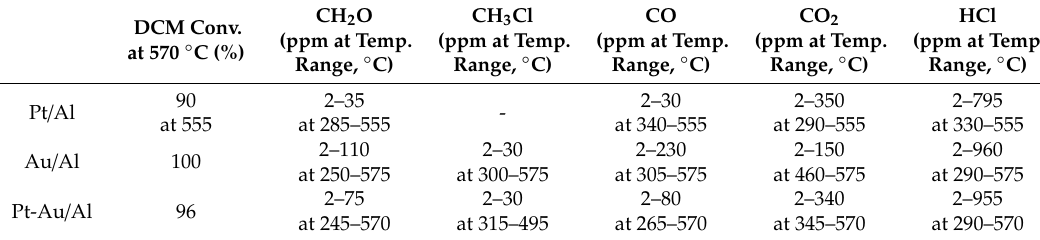
Table 5. The gaseous products detected during the light-o ff test (same conditions as in Figure 5). CH 2 O CH 3 Cl CO CO 2 DCM Conv. (ppm at Temp. (ppm at Temp. (ppm at Temp. (ppm at Temp. at 570 ◦ C (%) Range, ◦ C) Range, ◦ C) Range, ◦ C) Range, ◦